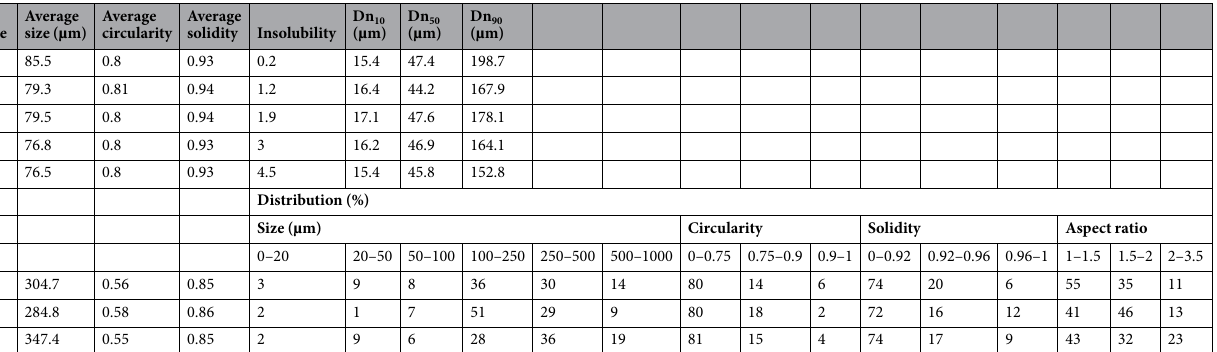
Table 1. Size-shape distribution of acid whey powder and fat filled milk samples based on image analysis. 1–5: Samples of acid whey powder with poor solubility. a–c: Samples of fat filled milk (FFMP). Average values are based on all particles for each sample. Distribution is based on the counts within an interval, compared to the total data array for a specific descriptor. Dn is based on number/count weighted distribution of particles, and not volume (Dv), for cumulative percentages 10, 50 and